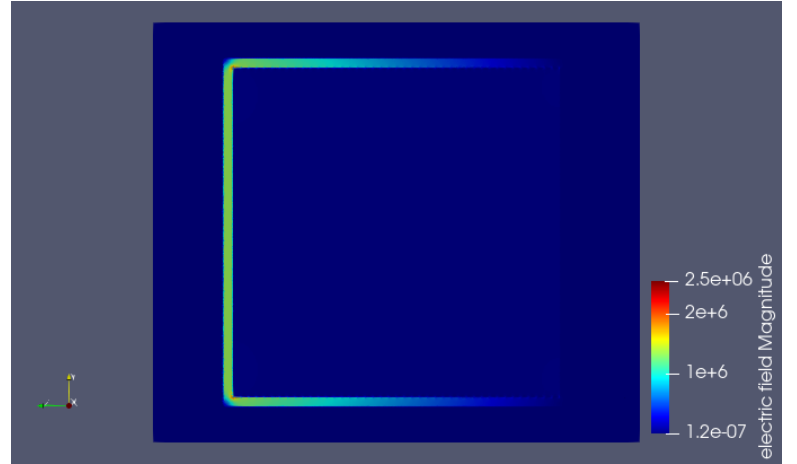
Figure 6. Electric field profile inside the pressure vessel for the single-anode design. In addition to the field profiles already given, voltage profiles generated by ParaView are also available in Figure 7. Although their usefulness as an analytical tool is limited, they clearly show that non-zero voltages only exist inside the TPC for both designs.